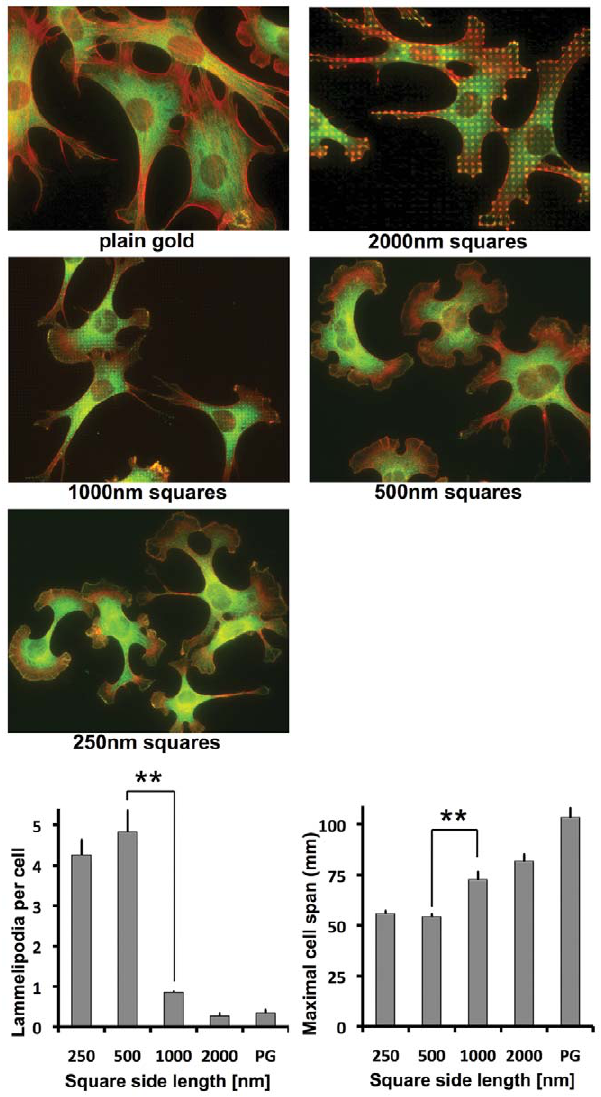
Figure 4. Fibroblasts on RGD-gold squares smaller than 1 m m 2 show altered morphology. Cells were grown on RGD-coupled gold patterns for 4 hours with 3% fibronectin-free serum and subsequently fixed and stained with Alexa-labeled phalloidin (red) and anti-vinculin antibody (green). Scale bar is 50 m m. Note the high number of lamellipodia on the 250 nm and 500 nm patterns, which is quantified in the graph (bottom left). In addition, the maximal cell span was reduced on the smaller compared to the larger patterns (bottom right). PG=Plain gold. Values indicate the mean 6 S.E.M. from three independent experiments including $ 30 cells per pattern size; **p , 0.01. doi:10.1371/journal.pone.0025459.g004 in lamellipodia and also in the cell body. At the rear end of protruding lamellipodia, the orientation of the meshwork was parallel to the cell border. To quantify our observations, images from three independent experiments with a total of around 50 cells per pattern were evaluated. The threshold of the 8-bit pictures was set to a grey value of 150, and remaining visible structures with a fibrous shape were counted as actin stress fibers. The number of stress fibers above threshold increased from almost zero on the 250 nm and 500 nm patterns to 2–3 on the 1000 nm and 2000 nm patterns, and up to 5 in average on plain RGD-gold